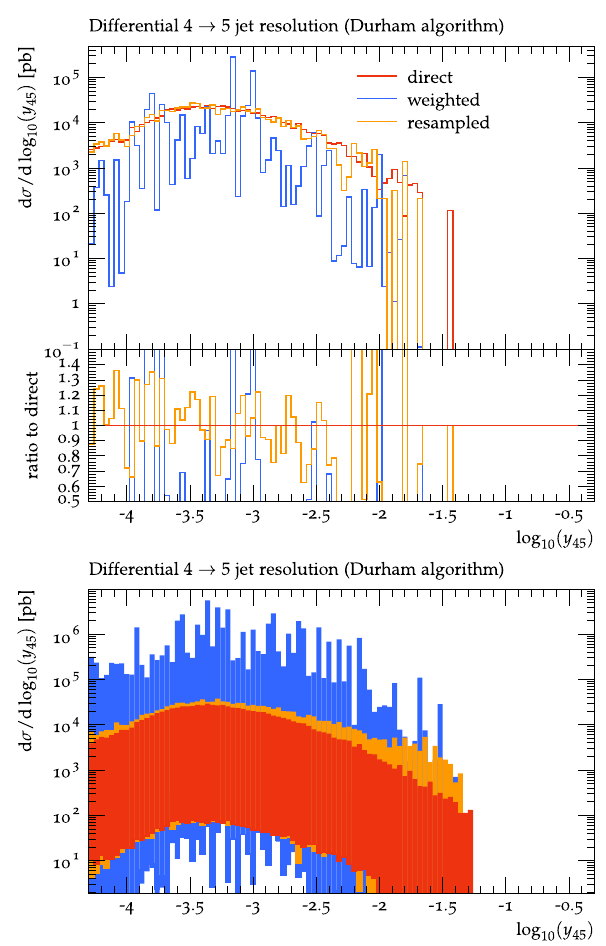
Fig. 3 The Durham y 45 observable as implemented in [23] (default). The same observable when sampled with Algorithm 2 without resam- pling (no resampling), and when sampled with interleaved resampling after each emission or rejection step in Algorithm 2 (resampling). In the lower panel we show the range of variation as in Fig.